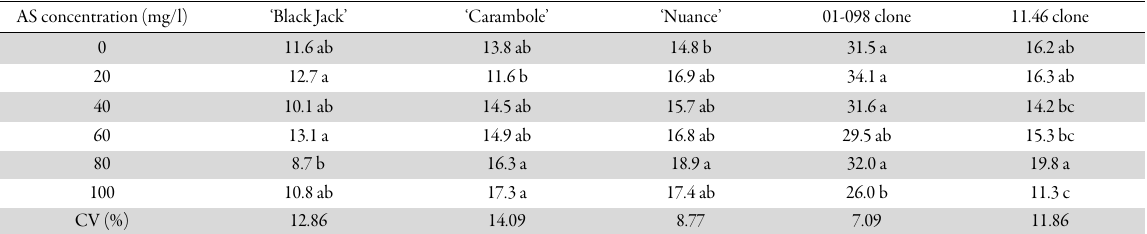
Table 6. Interaction effect of responses of varieties-clones and different concentrations of adenine sulphate on number of leaves produced per shoot subcultured